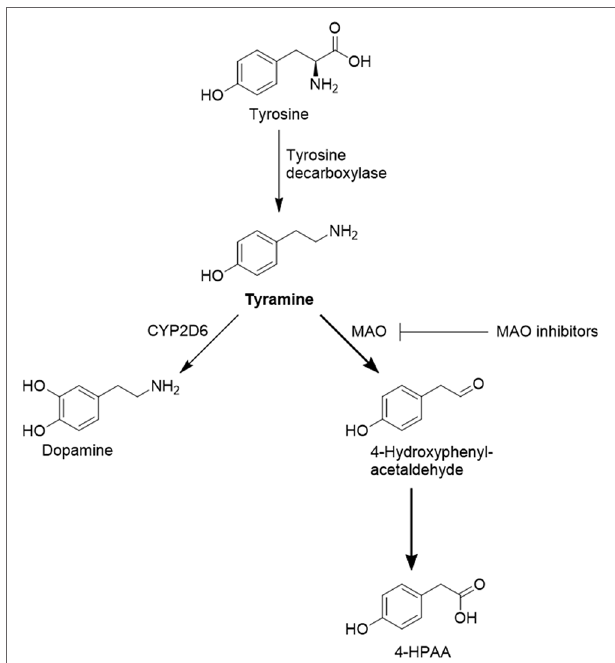
FigUre 1 | Selected pathways of tyramine formation and metabolism. Prior to oxidative deamination by MAO-A, tyramine has to traverse the cell membrane, most likely supported by organic cation transporters such as